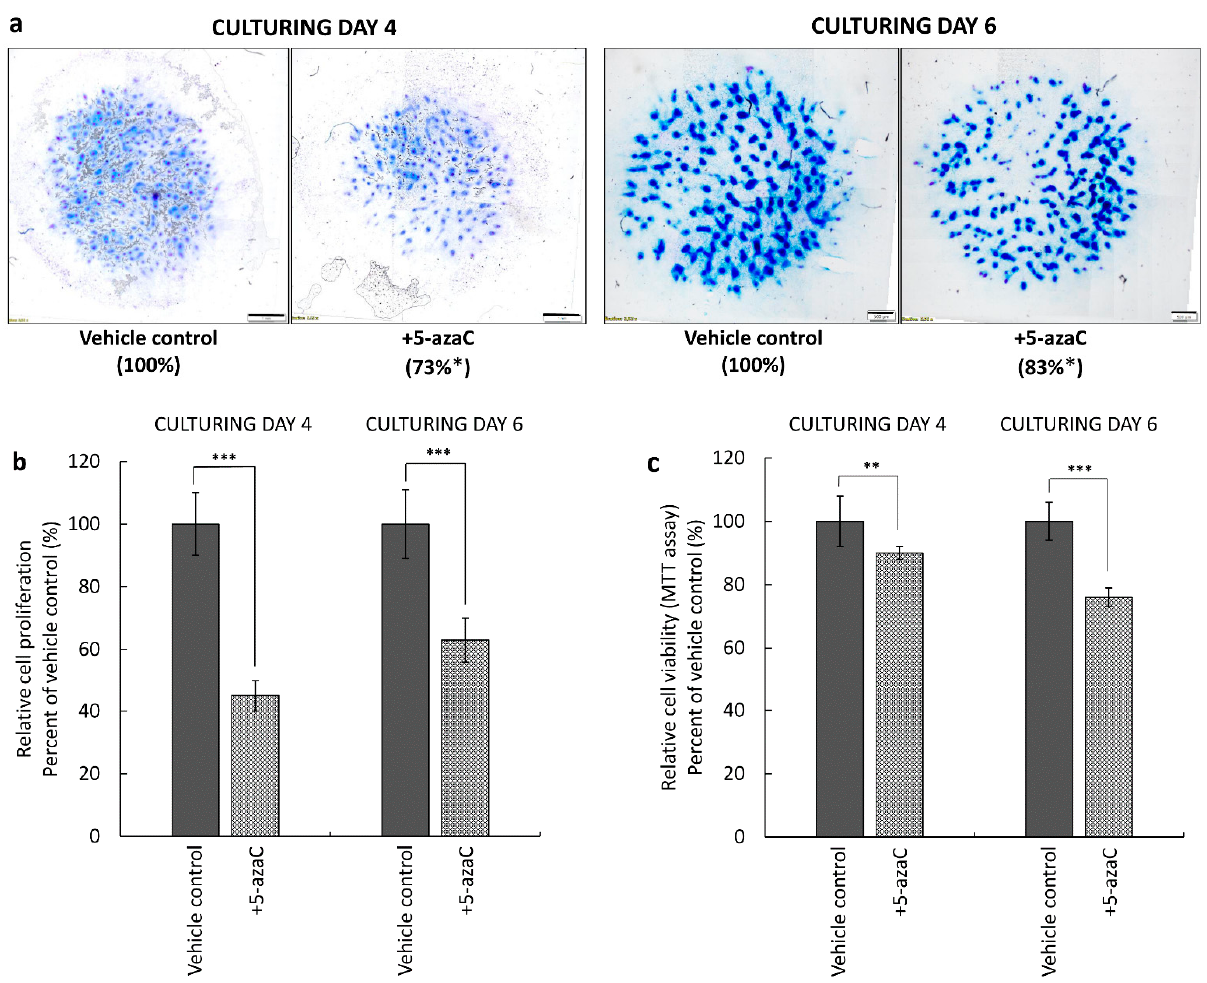
Figure 5. Effect of the DNA methylation inhibitor 5-azaC on cartilage ECM production, cell proliferation, and cell viability. ( a ) Metachromatic staining of 4- and 6-day-old primary chondrifying micromass cultures. 5-azaC (or DMSO as the vehicle control) was applied from the first or the third day of culturing, respectively, for 72 h at a final concentration of 10 µ M. Metachromatic ECM accumulation was visualized by dimethyl-methylene blue (DMMB) qualitative staining assay, and the proportion of the metachromatic area was analyzed by MATLAB application (percentages are indicated under the photomi- crographs). Original magnification was 4×. Scale bar: 1000 or 500 μ m. Effects of 5-azaC on ( b ) cell proliferation and ( c ) cell